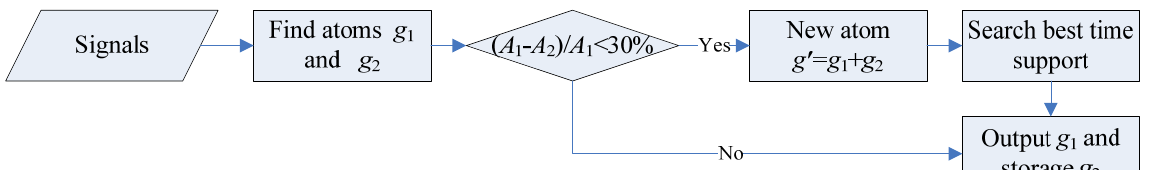
Figure 6. Block diagram of the double-atom decomposition